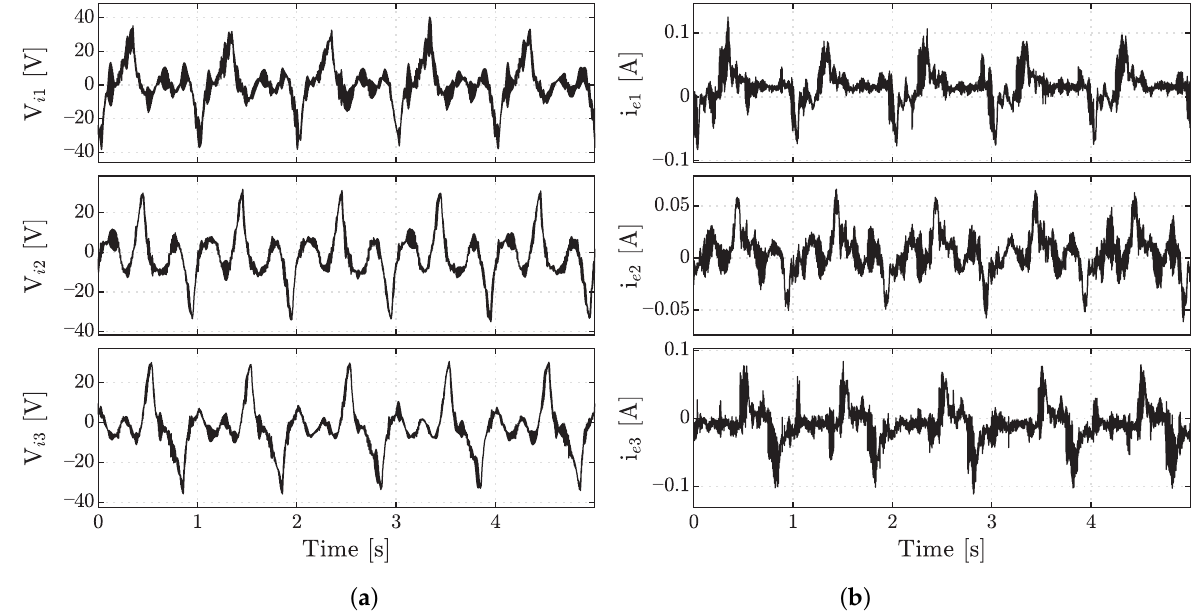
Figure 7. Experimental results. ( a ) Induced EMF. ( b ) Input submodule current.